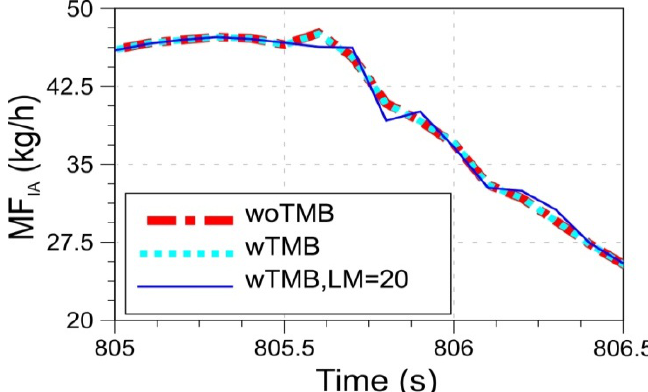
Figure 7. Zoom-in into the segment of the NEDC, which exposes minor differences of the intake mass flow calculated with the wTMB,LM = 20 compared to ones calculated with the woTMB and